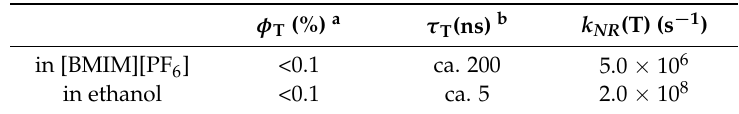
Table 2. φ T , τ T , and k NR for the triplet state ( k NR (T)) of the ligand L of helical Gd complex as GdL in [BMIM][PF 6 ] and in ethanol at 77 K ( a : λ ex = 328 nm, λ mon = 400–600 nm, b : λ ex = 340 nm, λ mon = 488 nm).